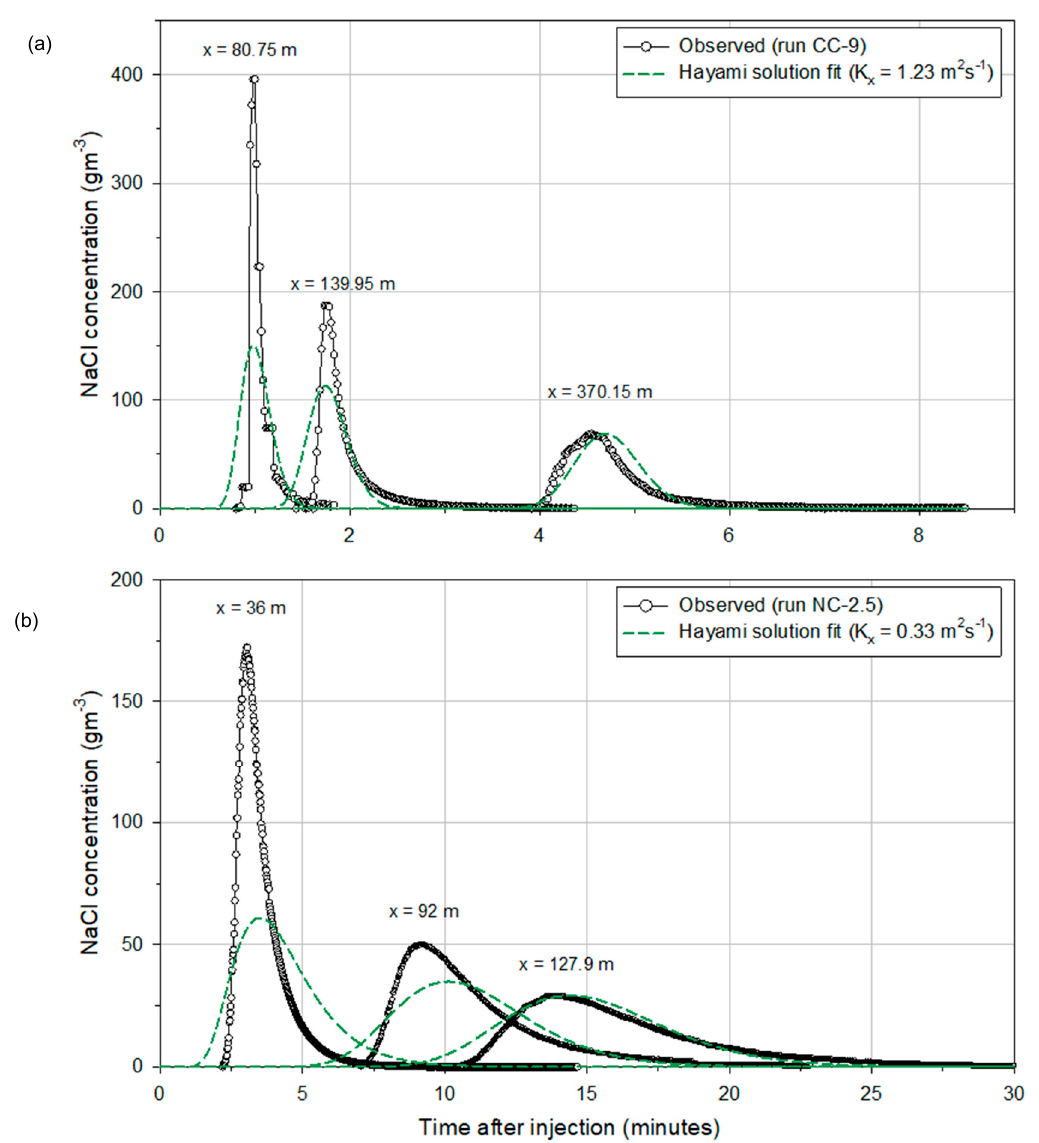
Figure 7. Modeled concentration curves based on the equilibrium longitudinal dispersion coefficient versus measured concentration curves. ( a ) Concrete channel; sampling locations x = 80.75 m and x = 139.95 m were located in the advective zone, and x = 370.15 m was located in the equilibrium zone. ( b ) Natural stream; sampling locations x = 36 m and x = 92 m were located in the advective zone, and x = 127.9 m was located in the equilibrium zone.